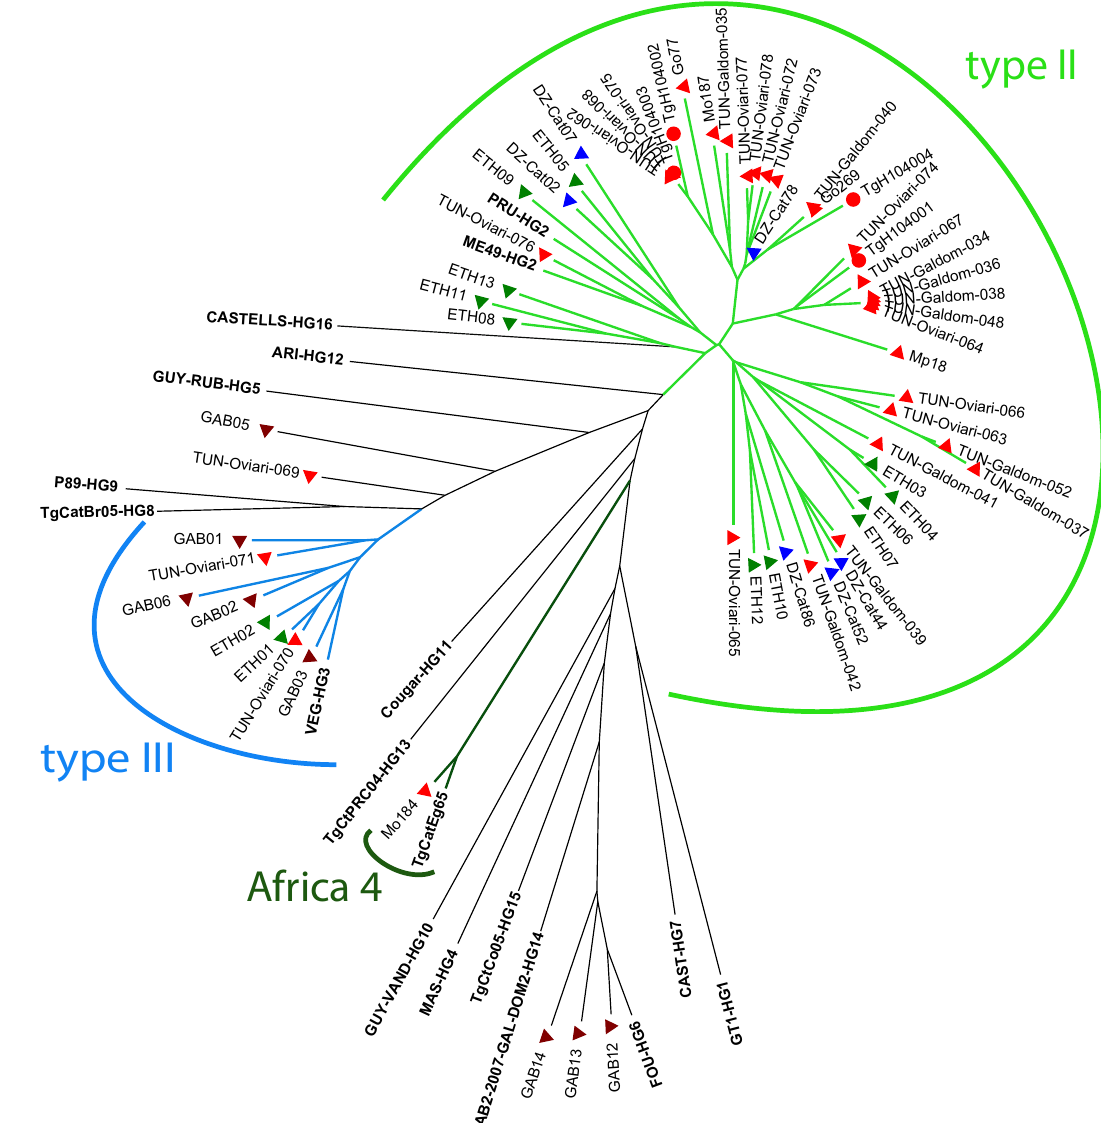
Figure 1. Neighbor-joining (NJ) tree of genotypes inferred from Cavalli–Sforza distances calculated from the data of 15 microsatellite markers for the 33 strains described in this study (red triangles) and a set of strains from previous studies: Human Tunisian strains (red circles), African strains (blue triangles for Algeria, green triangles for Ethiopia and brown triangles for Gabon) and reference strains representing the global diversity of Toxoplasma gondii . Reference strains and their respective haplogroups (HG) are indicated in bold letters when available (for details refer to Supplementary Table S2). Coloured branches in the NJ tree correspond to the T. gondii lineages found in Tunisia: type II lineage in light green, type III lineage in blue and Africa 4 lineage in dark green. This figure was drafted by L.G. in Adobe Illustrator CS6 (http:// www. adobe. com/ fr/ produ cts/ illus trator.